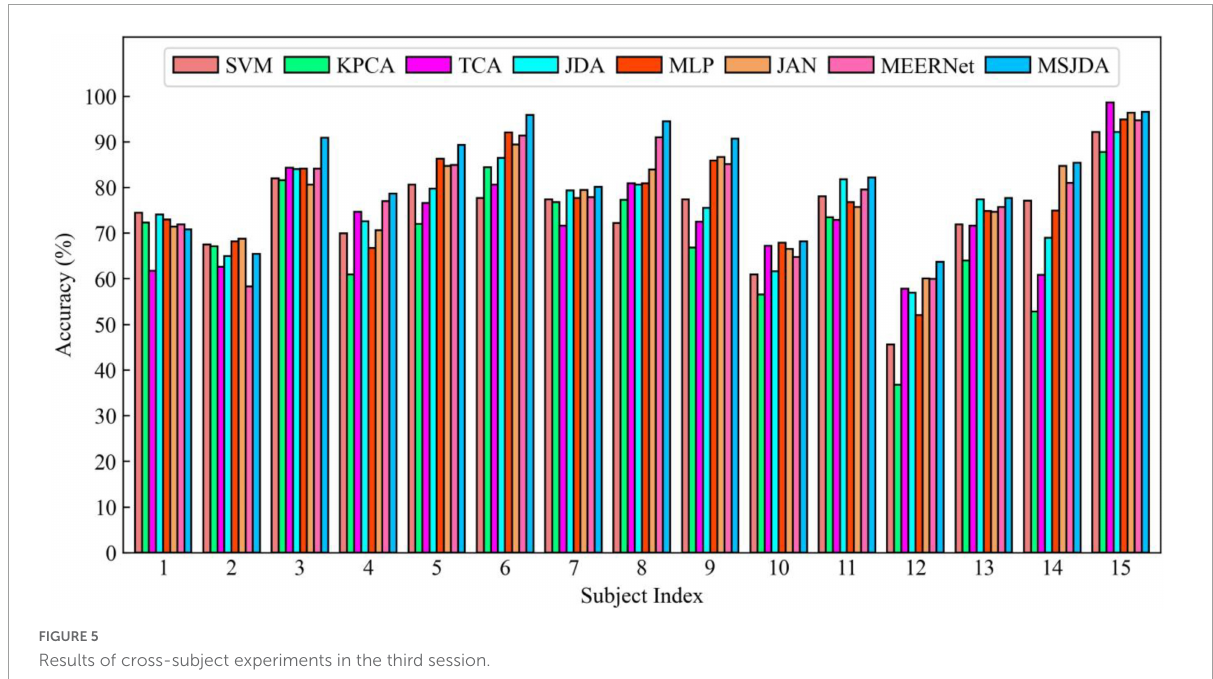
FIGURE5 Results of cross-subject experiments in the third session.